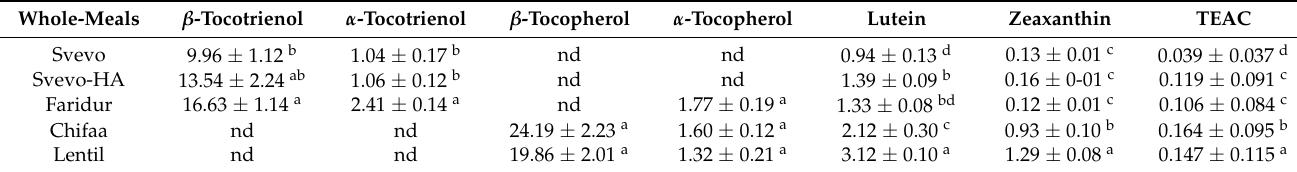
Table 3. Composition of Svevo, Svevo-HA, Faridur, Chifaa and lentil wholemeal flours for isoprenoids expressed as µg/g d.m. a-d Different letters within each column show significant differences ( p < 0.05). Non-detected (nd).